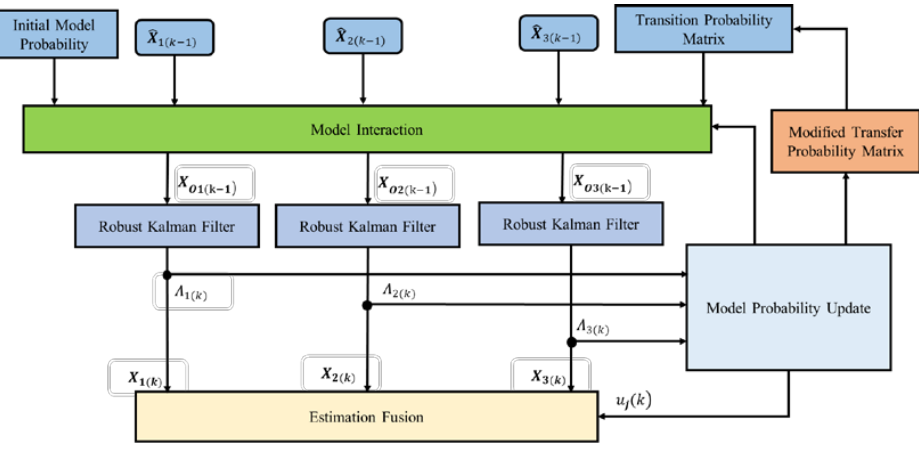
Figure 4. Robust IMM diagram.